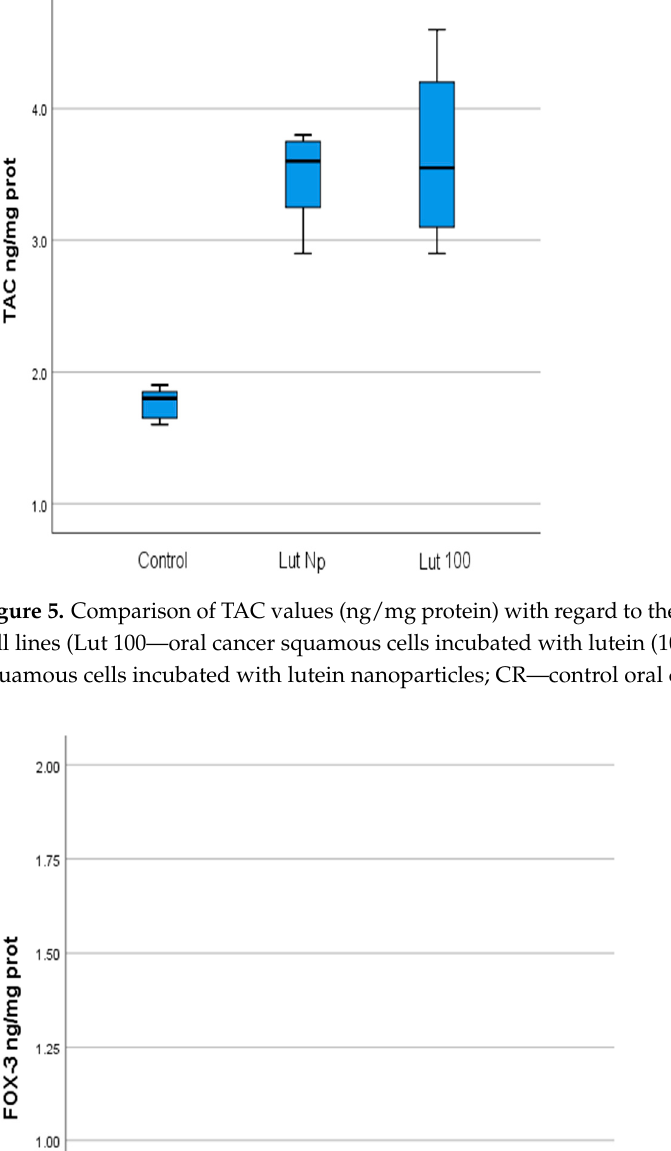
Table 6. Comparison of post hoc MMP-9 results (pg/mg protein) with regard to the batches of studied OSSC cell lines (Lut 100—oral cancer squamous cells incubated with lutein (100 mg); Lut Nps—oral cancer squamous cells incubated with lutein nanoparticles; CR—control oral cancer squamous cells).